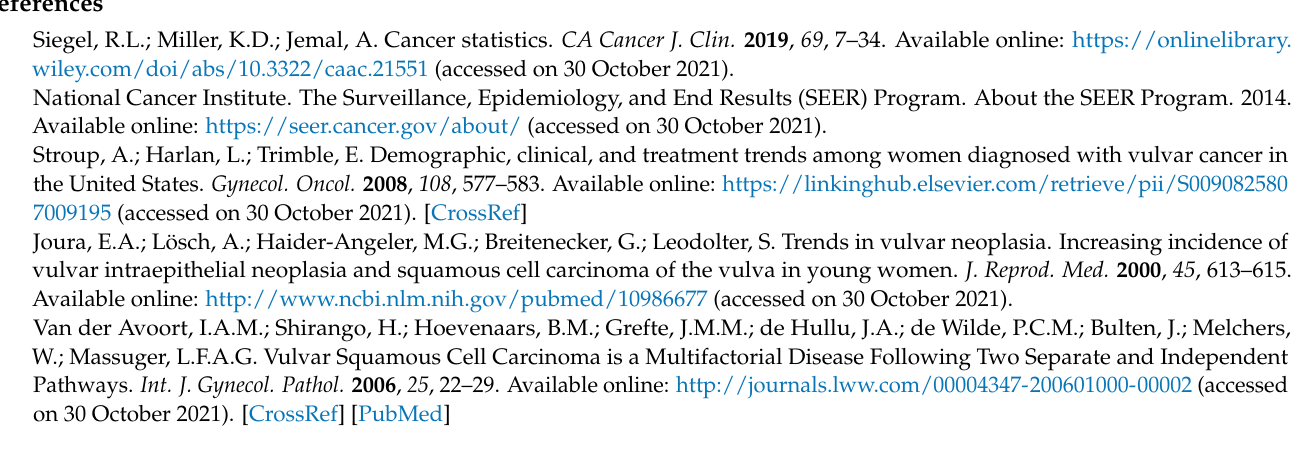
figure preparation, F.M.; writing—review and editing, all the authors; supervision, S.C., L.O. and C.B. All authors have read and agreed to the published version of the